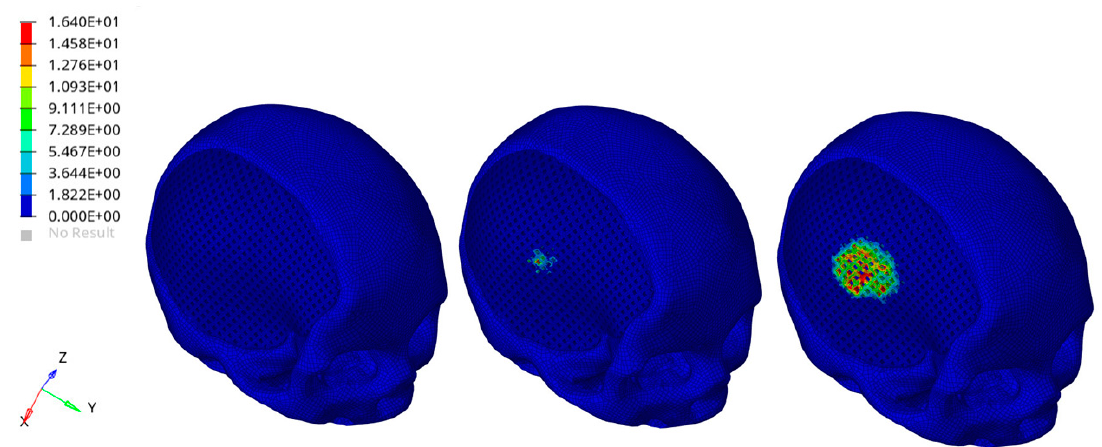
Figure 12. Biomechanical response as a result of the rigid sphere impacting the implant zone region of the head: von Mises stress (MPa) distributions for the 3D PCL structure underneath the external cement layer and infiltrated with the bone cement, at three different times after the initial impact ( left ). Bone cement was removed to visualize the effect of the impact for the selected component. The color scale was chosen to allow for comparison among the models at different times.